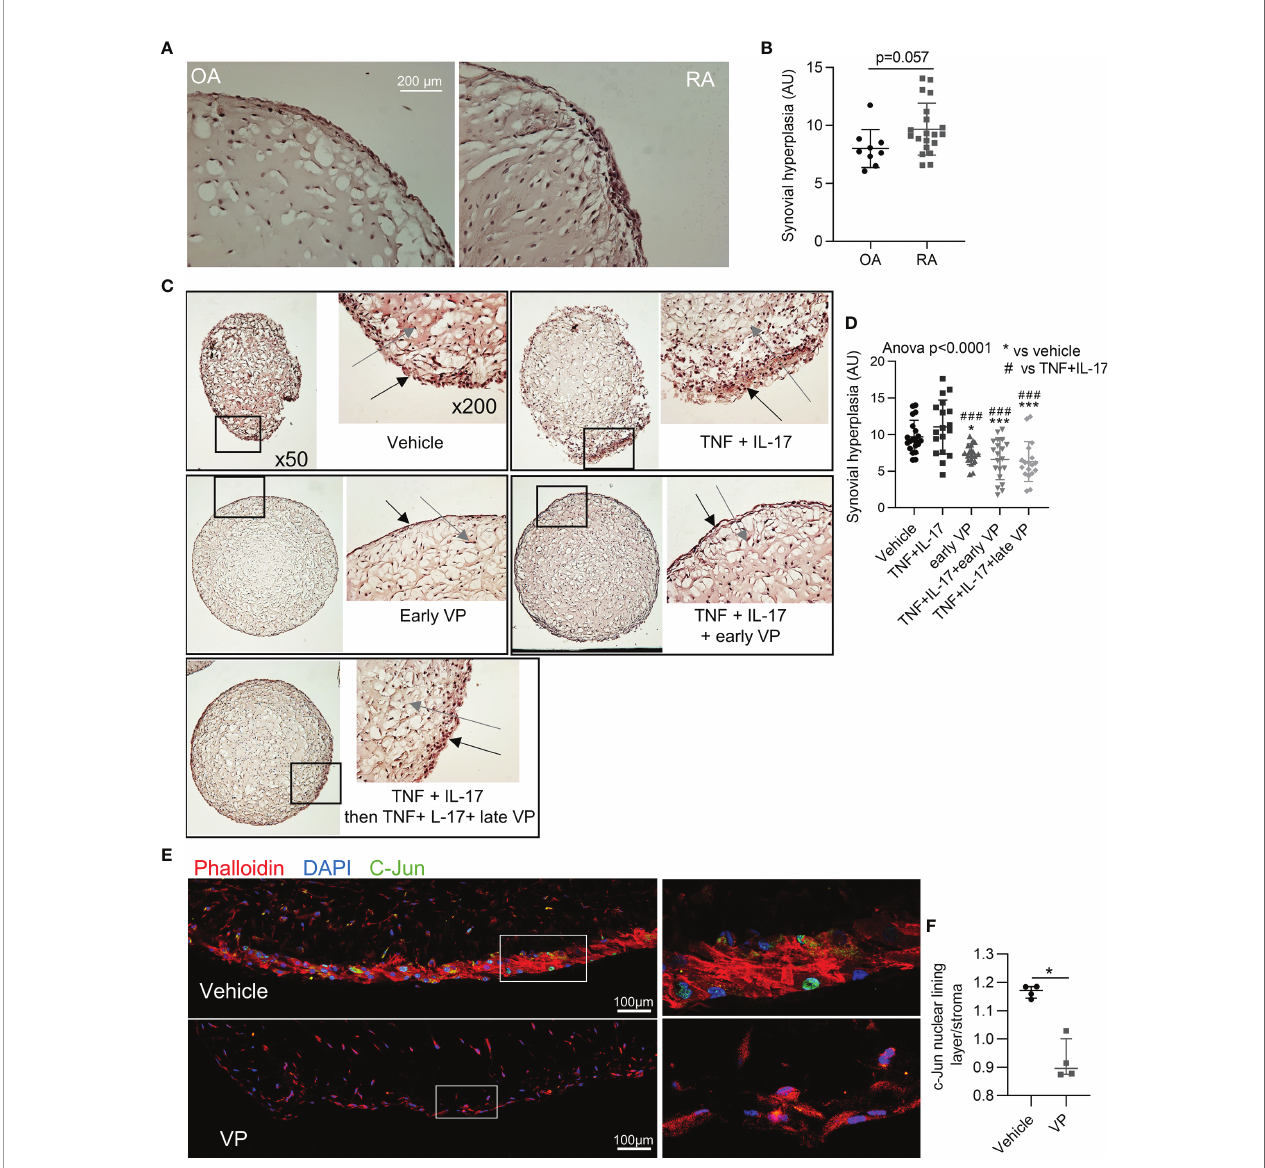
FIGURE 4 | Prevention and reversal of synovial hyperplasia in a synovial organoid model by YAP/TAZ inhibition. (A, B) Representative images at x200 magni fi cation after H&E staining of synovial organoids (A) with quanti fi cation (B) of synovial hyperplasia in organoids (n=9 for OA and 20 for RA) from RA (4 patients) and OA (3 patients) FLS. (C) Representative images at x50 and x200 magni fi cation after H&E staining sections of synovial organoids with RA FLS from the same patient; black arrows: synovial lining layer, grey arrows: synovial stroma. (D) Corresponding quanti fi cation of synovial hyperplasia in organoids (n=15 to 20 per group) from RA FLS (n=4 patients). * comparisons vs. vehicle, # comparisons vs. TNF+IL-17. (E) Representative confocal tiles images at x630 for c-Jun (green), phalloidin (actin, red), and DAPI (nucleus, blue) on RA organoid with corresponding zoom (right). (F) Ratio of nuclear c-Jun for cells in lining layer and nuclear c-Jun for cells in the stroma (organoids n=4 from FLS of one RA patient). Data were presented as individual values with mean ± SD (B, D) or median with interquartile range (F) . T-test (B) , ANOVA test with FDR post hoc test corrected (q-value) for multiple comparisons (D) or Mann-Whitney (F) . *q or p < 0.05; ### q < 0.001). VP, 10 µM; TNF, 10 ng/ml; IL-17, 50 ng/ml; AU, arbitrary